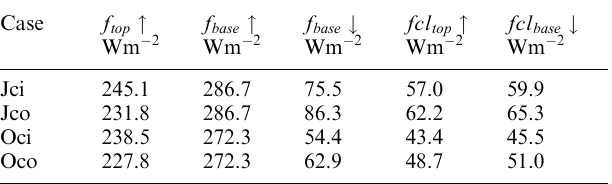
Table 4. Radiative fluxes in the terrestrial spectral range; f top " : upward flux at cloud top, f base " : upward flux at cloud base, f base # : downward flux at cloud base, fcl top " : upward flux at cloud top (cloud only), fcl base # : downward flux at cloud base (cloud only), other designations as in Table 3 Case